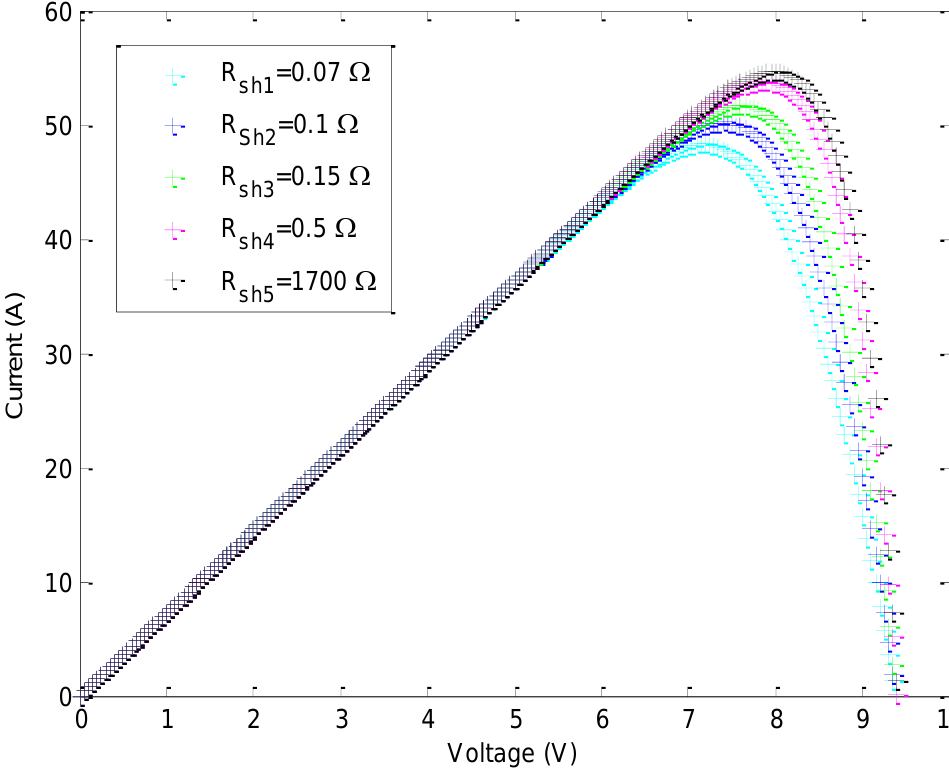
Figure 5. P-V characteristic curves for parametric variation of shunt resistance.